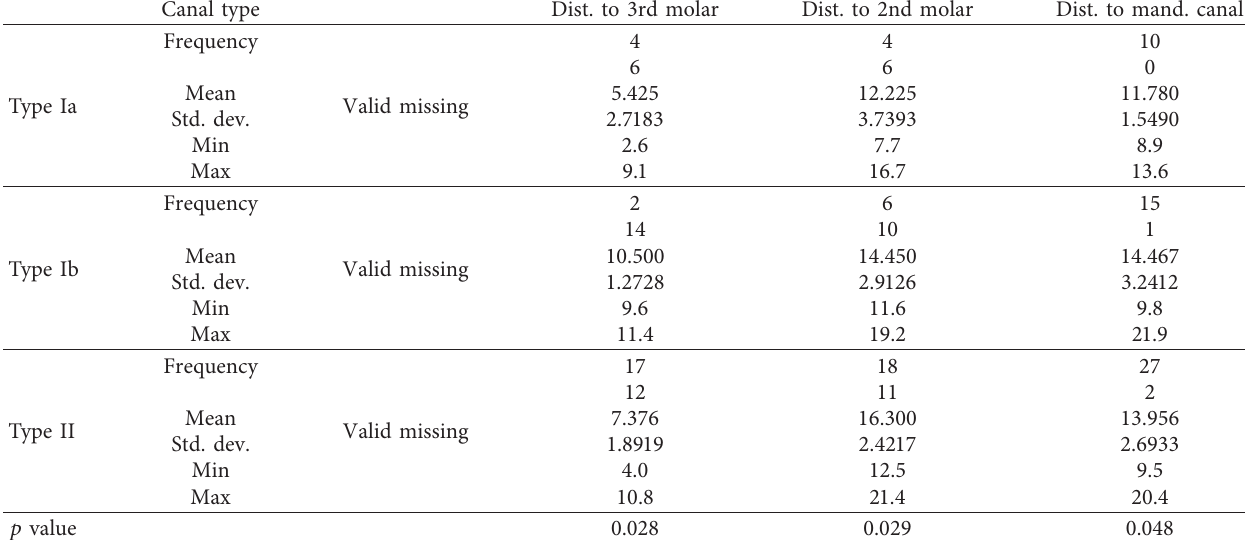
Table 4: Distance of different types of retromolar canal to third and second molars and mandibular canal.